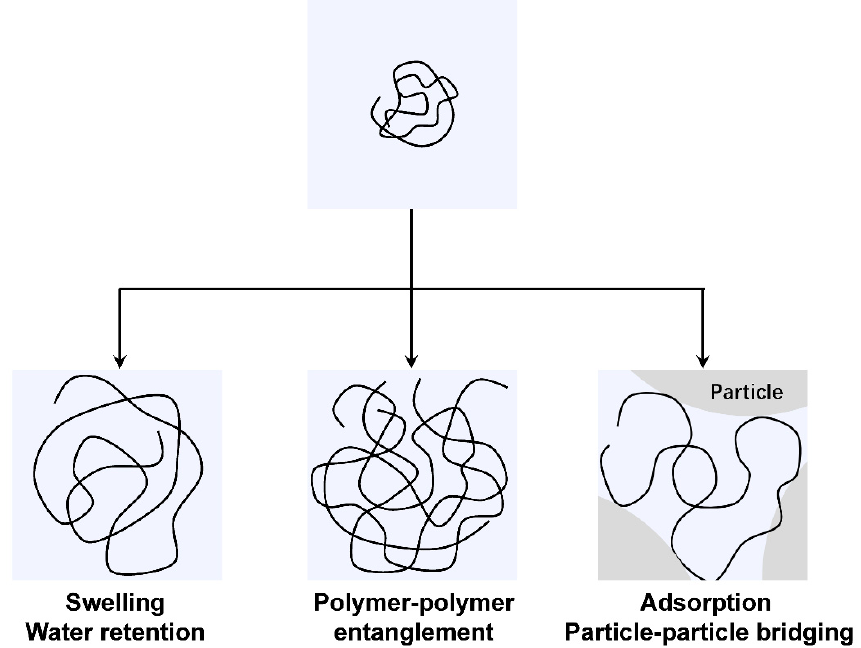
Figure 14. Schematic illustration of the action mechanism of VMAs.